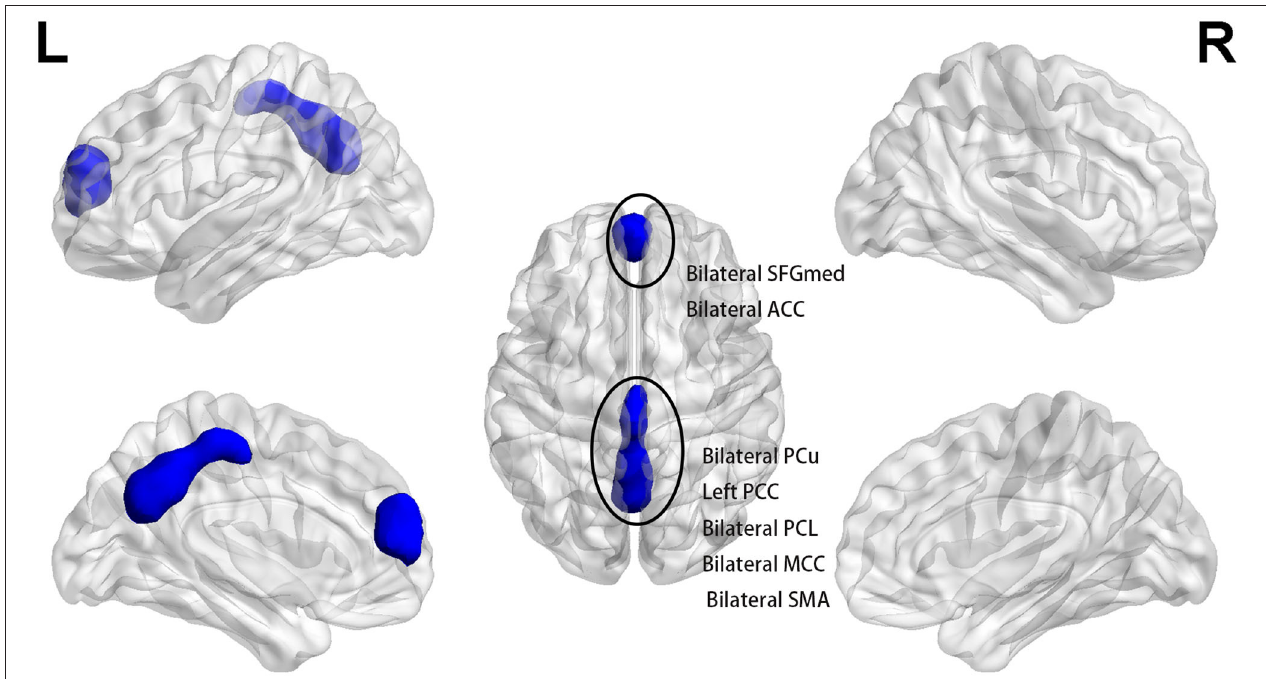
FIGURE 1 | At baseline, patients exhibited lower slow 5 fALFF in bilateral SFGmed and bilateral ACC (cluster A) and bilateral PCu, left PCC, bilateral PCL, bilateral MCC, and bilateral SMA (cluster B) when compared with healthy controls ( p < 0.025, FWE corrected, CZ = 100). SFGmed, medial superior frontal gyrus; ACC, anterior cingulate; PCu, precuneus; PCC, posterior cingulate; PCL, paracentral lobule; MCC, middle cingulum; SMA, supplementary motor